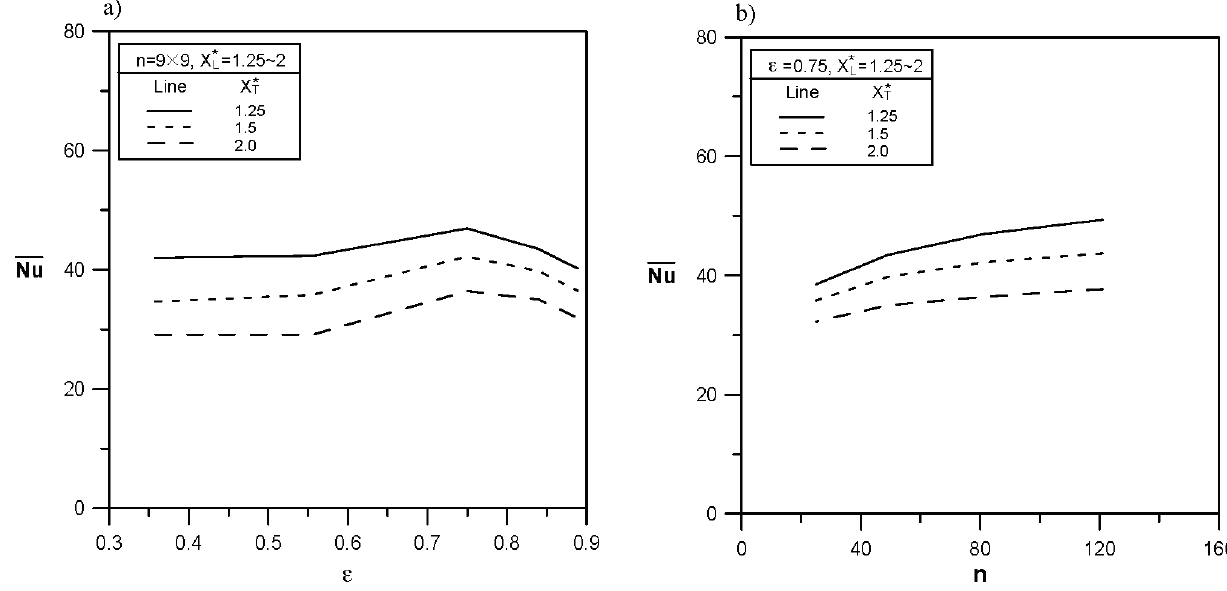
Figure 15. Average Nusselt numbers of pin-fin heat-sink array: ( a ) effect of heat-sink porosity and ( b ) effect of pin-fin